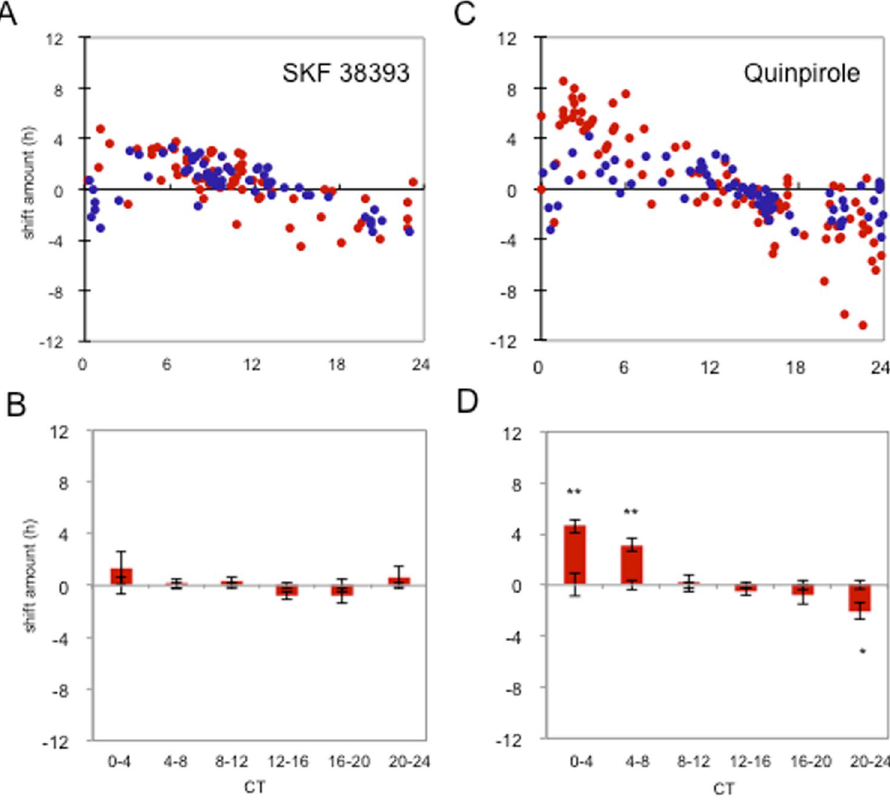
Figure 3. Effects of D 1 -like agonist (SKF38393) and D 2 -like agonist (Quinpirole) on PER2::LUC bioluminescence rhythm. 50 µ M of SKF38393 did not phase-shift the PER2::LUC bioluminescence rhythm ( A and B ), whereas quinpirole significantly phase-advanced PER2::LUC bioluminescence rhythm at CT 0–4 and CT 4–8 hrs and phase-delayed when applied at CT 20–24 ( C and D ). Blue circles indicate cultures treated with vehicle and red circles indicate culture treated with active compounds. Data were divided to 6 bins at 4-hour intervals for statistical analysis (Two-way ANOVA following Tukey tests, * p < 0.05). n = 3–21 for each bin ( B and D ). Data were then used to calculate the phase change of drug treated versus their vehicle controls. Bars show the mean amount of phase change from controls and error bars show ± SEM for experimental groups. Error bars from x axis show ± SEM for control